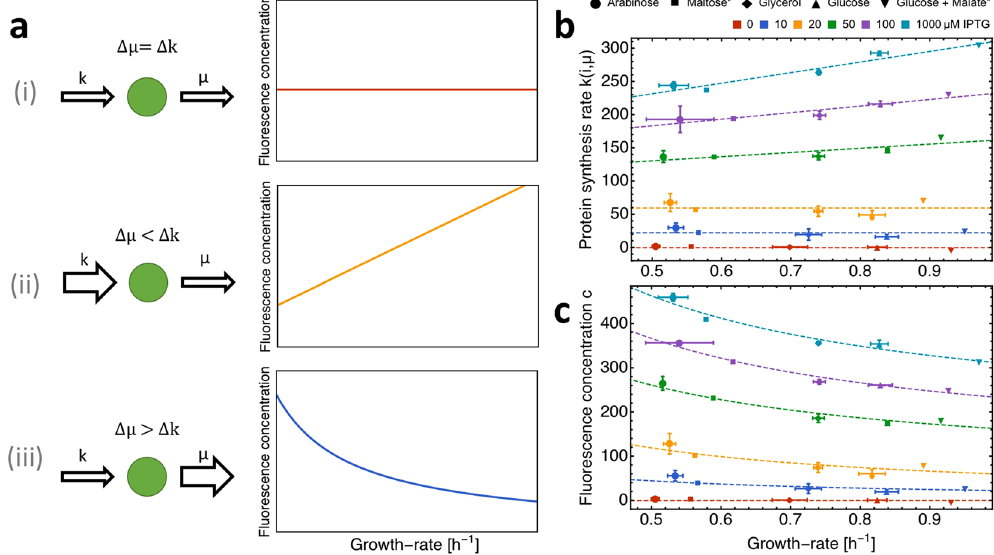
Figure 3. Reduced protein expression by dilution by growth is partially compensated for by enhanced protein synthesis rate at higher growth rates. ( a ) Three scenarios can be distinguished for the response of protein synthesis rate to an enhanced growth rate: (i) perfect compensation, (ii) overcompensation and (iii) undercompensation. ( b ) Protein synthesis rate k is invariant to growth rate at low IPTG concentrations and increases linearly with growth rate at intermediate to high IPTG concentrations. Dashed lines are linear fits to the data. ( c ) The change in protein concentration as function of growth rate is dominated by dilution by growth. At IPTG concentrations above 50 μ M, an increased protein synthesis rate partially compensates dilution by growth. Dashed lines, model predictions from equation 1 using fitted linear functions for k . Data points are either single experiments or the average of two biological replicates. Error bars show the standard error of the mean (SEM) of biological replicates. All individual experimental data points can be found in Fig. S15 in the Supplementary